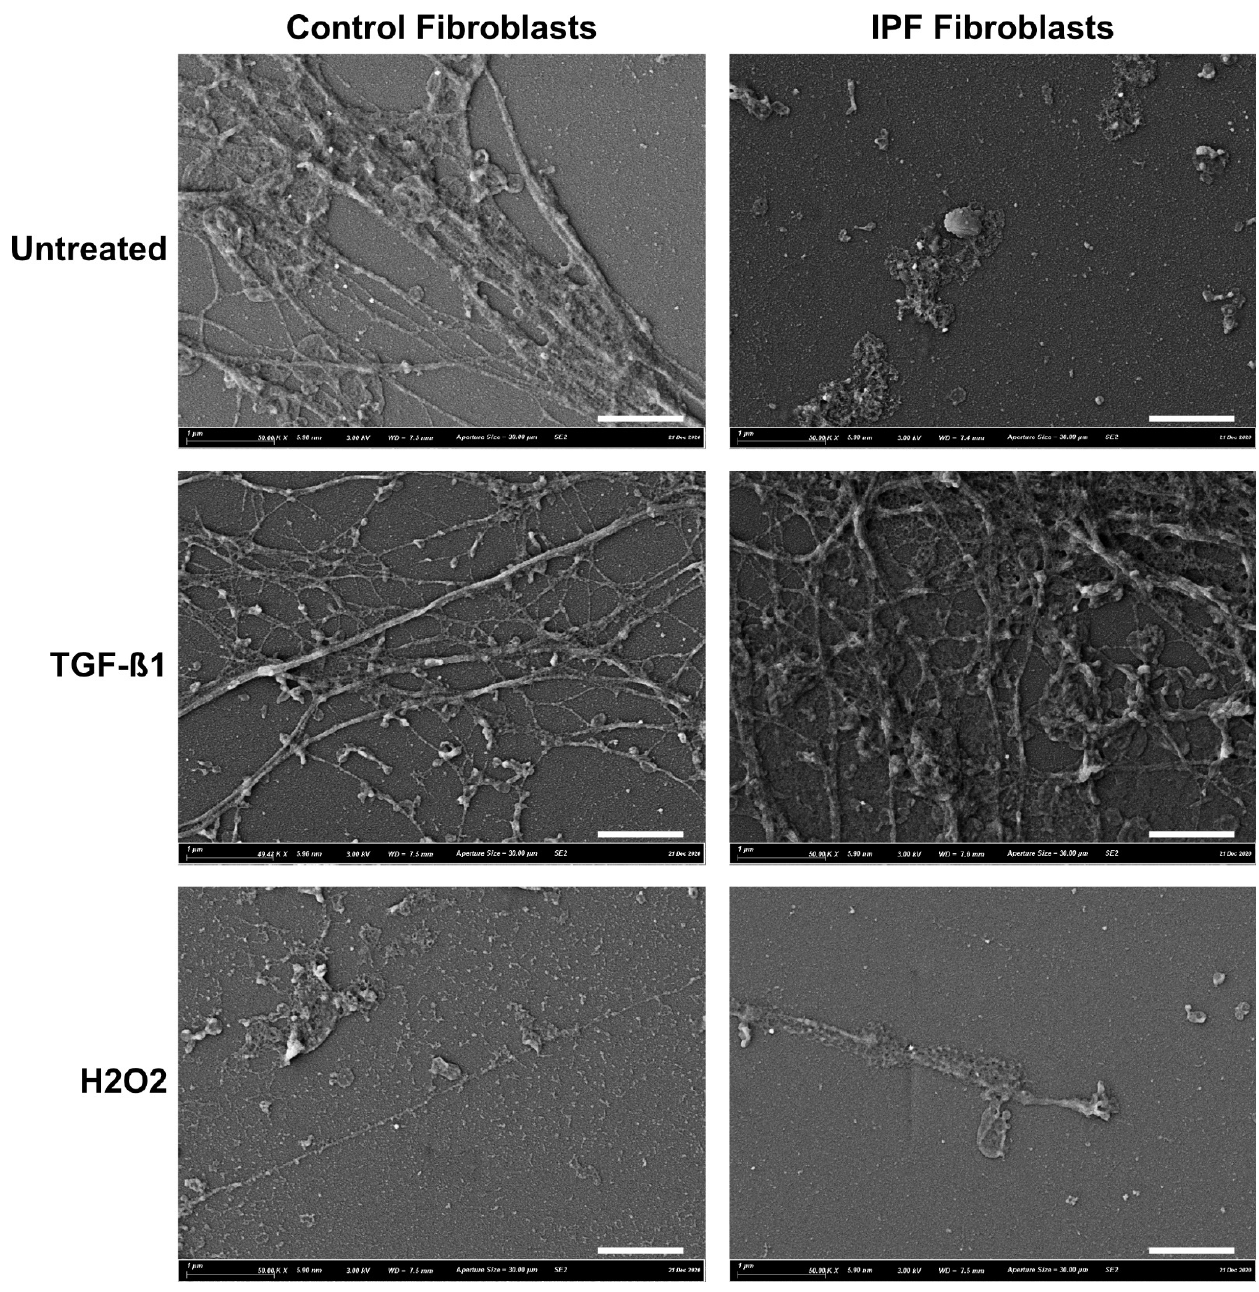
Figure 1. SEM images of deposited ECM from control and IPF fibroblasts. ECM preparation of Ctrl- and IPF-derived ECM under basal (untreated) or stimulated conditions (TGF- β 1 and hydrogen peroxide). Images show different cell-free deposited ECM proteins. Images are representative of two donors. Scale bar = 1 µM.